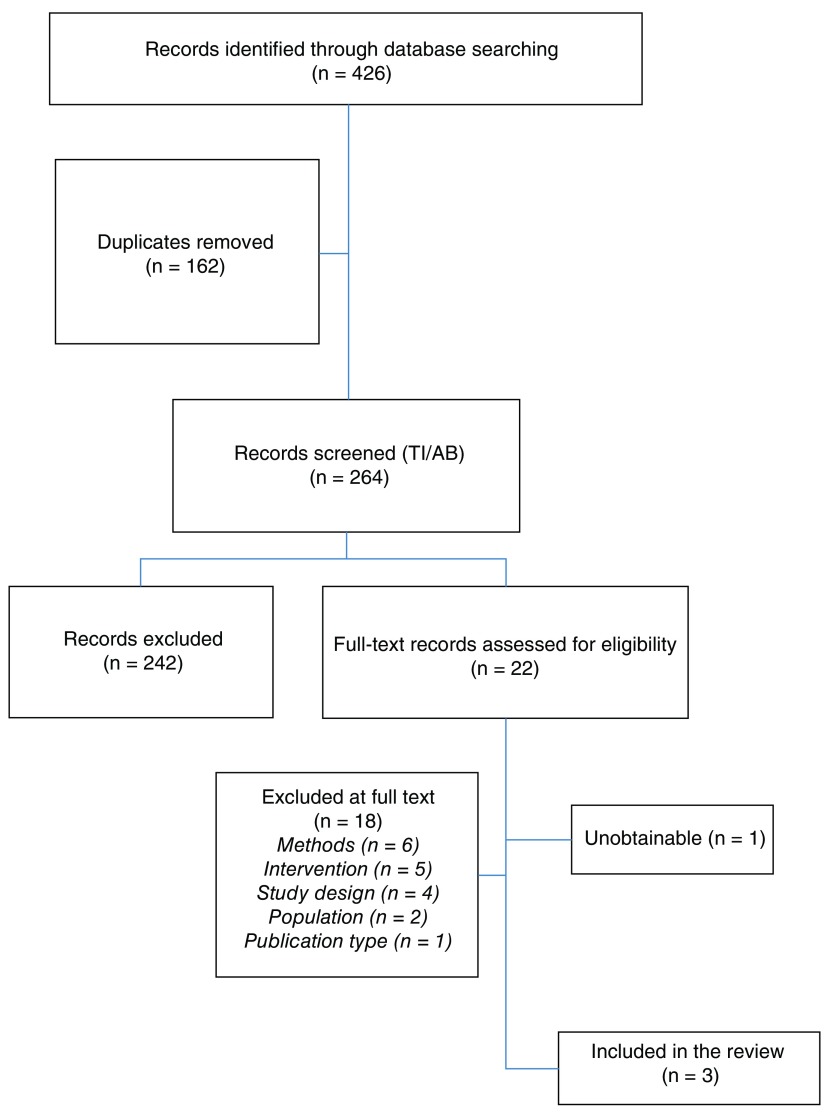
PRISMA flow diagram.